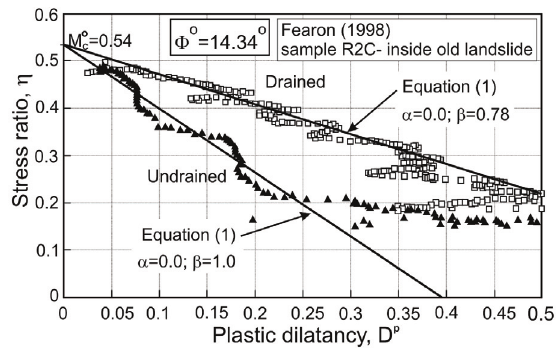
Fig. 10. Stress ratio-plastic dilatancy relationships for drained and undrained triaxial tests of samples from the inside of the Acquara-Vadoncello old landslide